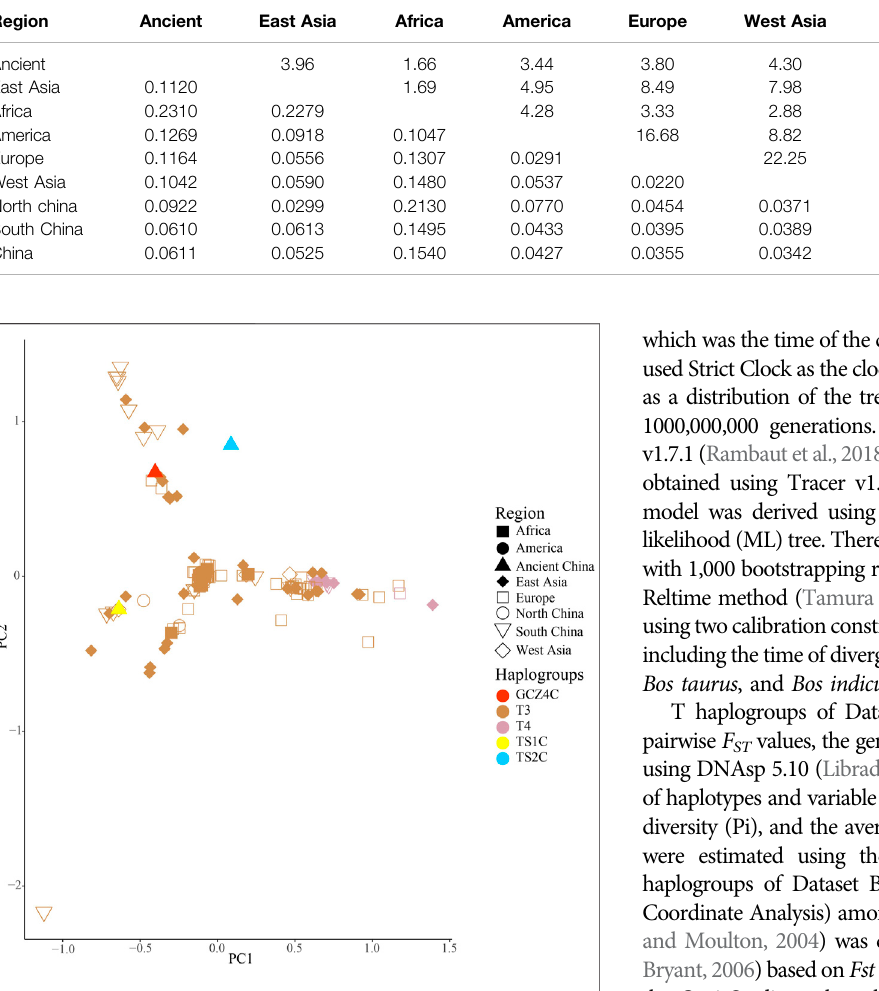
Frontiers in Genetics |